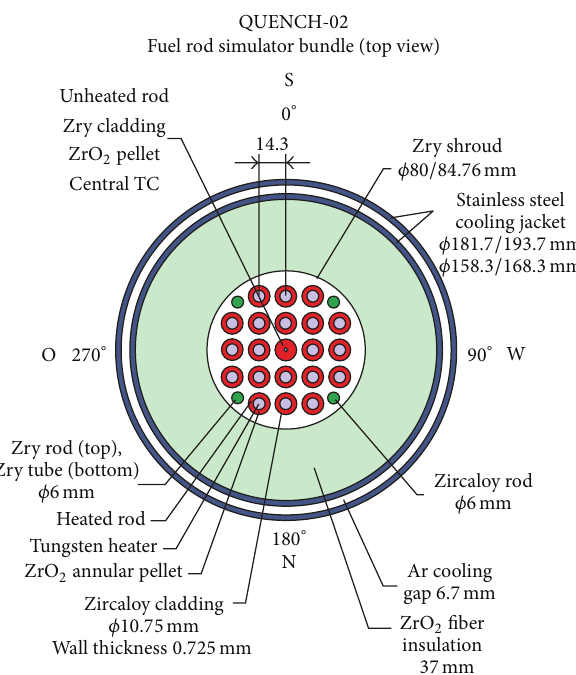
Figure 2: Test section and bundle cross-section of the QUENCH bundle [14].